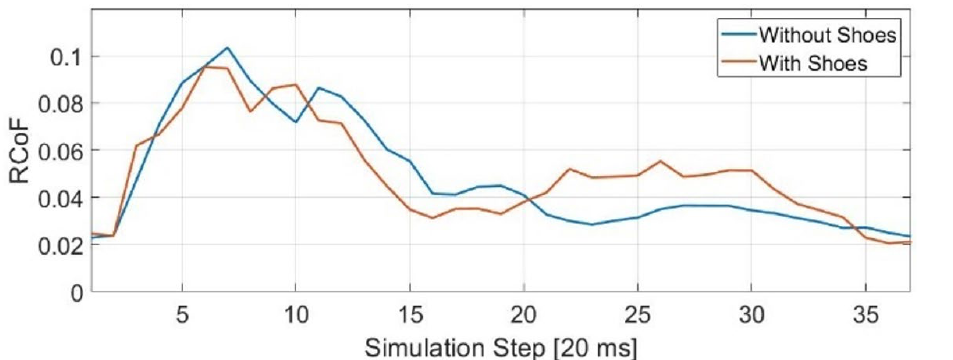
Figure 5. Example RCoF calculated from the GRF on a simulation with a walking seed of 6 cm/s and step length of 8cm on a no- slipping